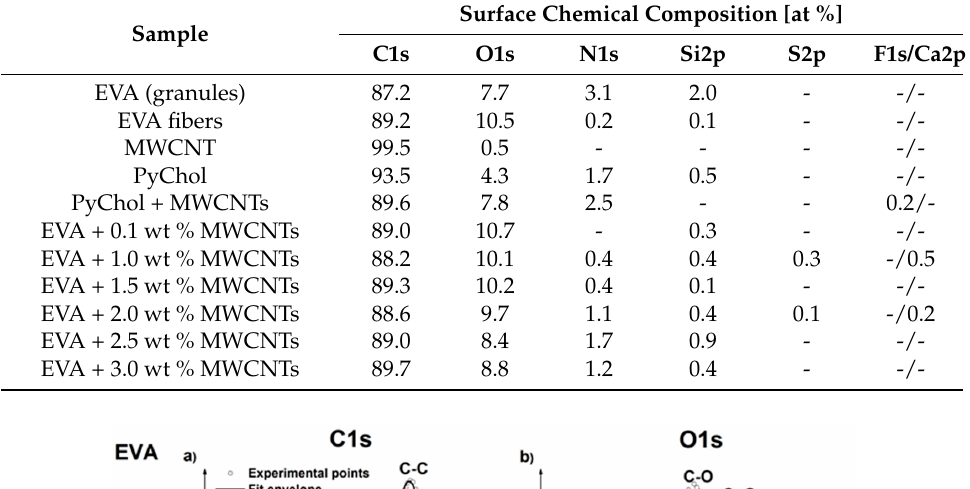
Table 1. Apparent surface chemical composition of EVA matrix, MWCNTs and surface modified